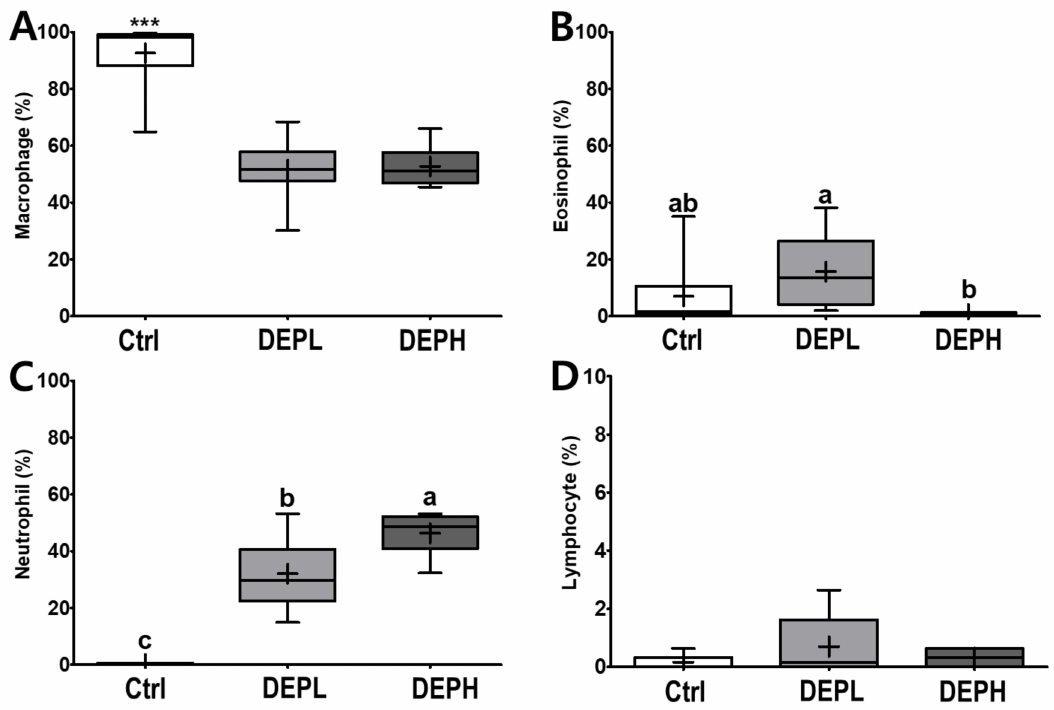
Figure 4. Box-and-whisker plots representing the relative ratio of inflammatory cell profiles in the broncho-alveolar lavage fluid (BALF) after repeated exposures to diesel exhaust particles (DEP) for 7 consecutive days. The ( A ) macrophages, ( B ) eosinophils, ( C ) neutrophils, and ( D ) lymphocytes are expressed as percentages of the total number of cells; n = 8 for each group. One-way ANOVA was performed, followed by Tukey’s post-hoc test; labeled means without a common letter differ ( p < 0.05); *** p <